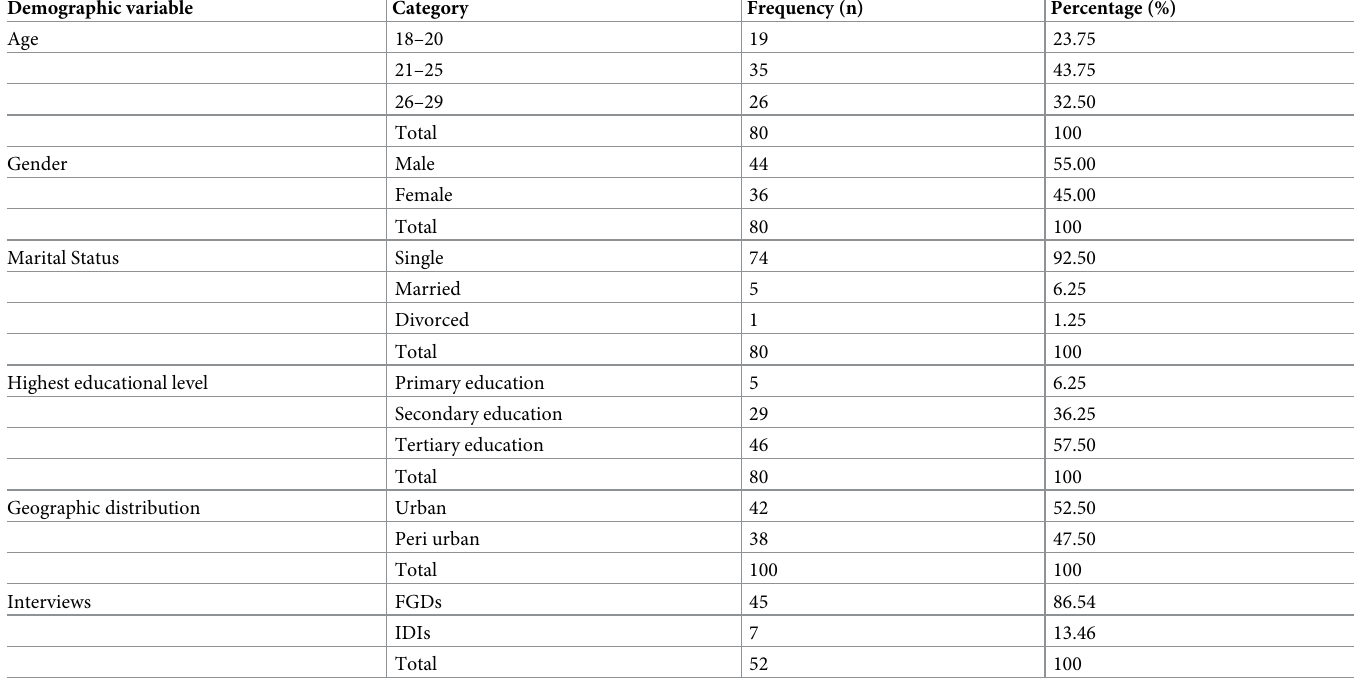
Table 1. Demographic characteristics of